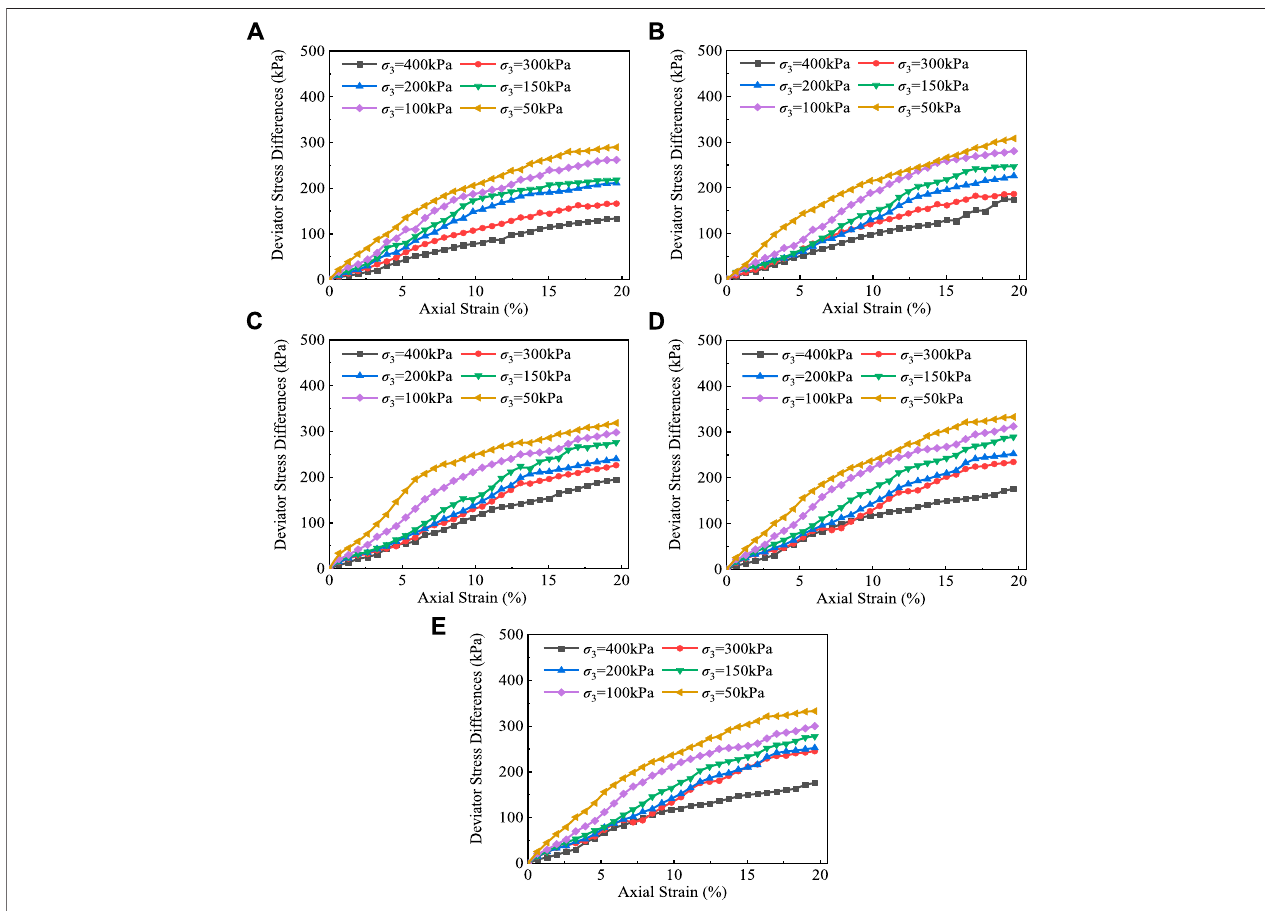
FIGURE11| Deviatorstressdifferences ofthetested claywith various FTcycles. (A) 1FT cycle. (B) 3FTcycles. (C) 6FT cycles. (D) 10FTcycles. (E) 15FTcycles